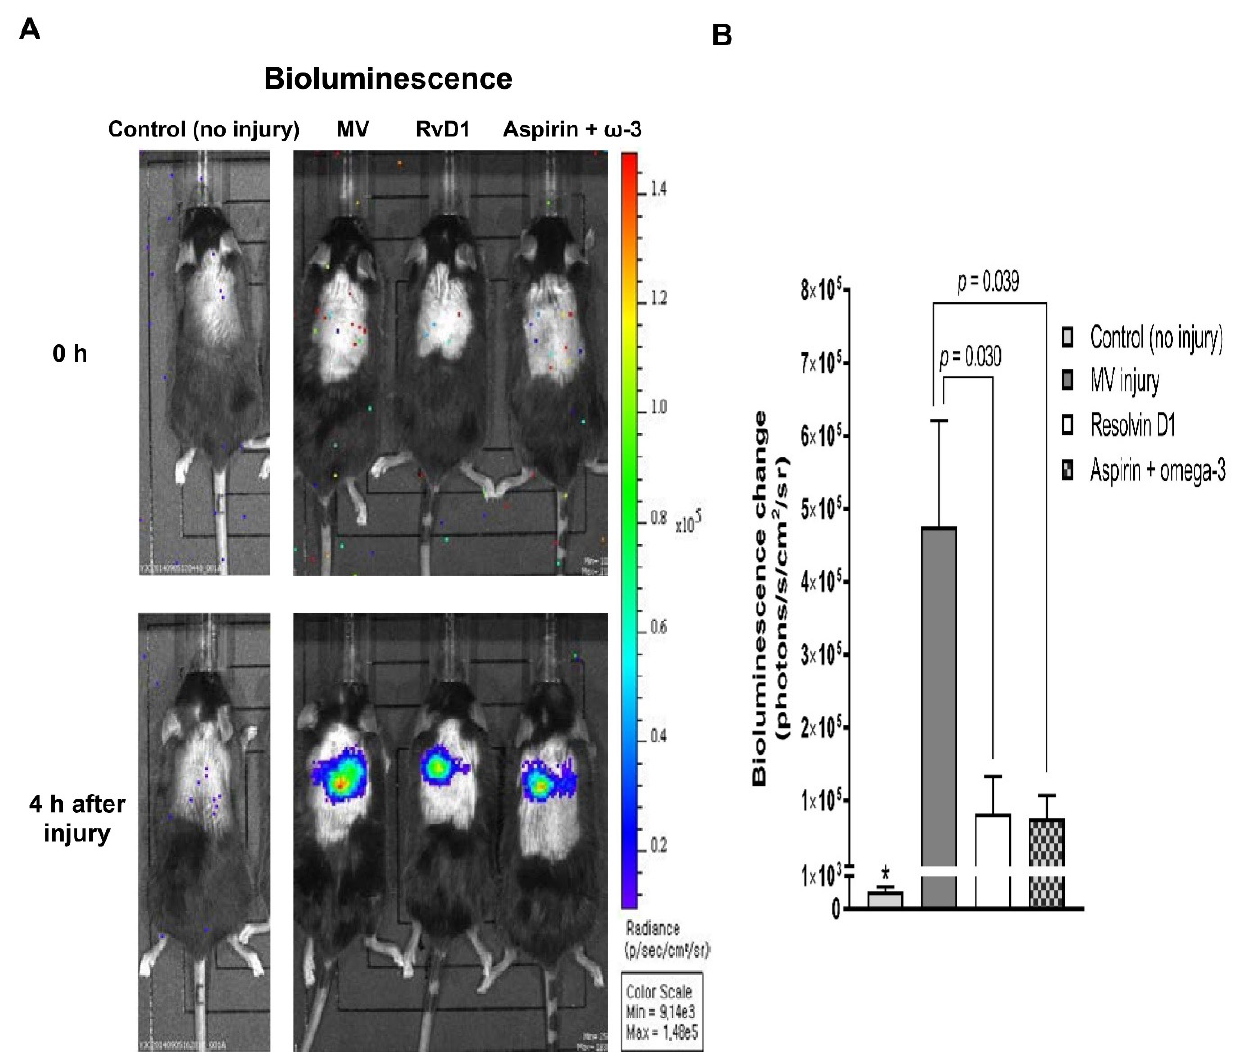
Figure 1. The effect of pretreatment group on NF- κ B induction in vivo. In NF- κ B-luciferase reporter transfected mice, the quantification of bioluminescence signal from the lungs was conducted at 4 h after MV injury. The number of mice in control, MV injury, resolvin D1 pretreated, and aspirin and omega-3 pretreated groups were 3, 9, 7, and 7, respectively. Data are presented as mean ± standard error of the mean. * p < 0.05 for value between control group and injury only group. ( A ) Bioluminescence images. ( B ) Lung signal intensity change. NF- κ B, nuclear factor kappa-light-chain-enhancer of activated B cells; MV, mechanical ventilation; RvD1, resolvin D1.